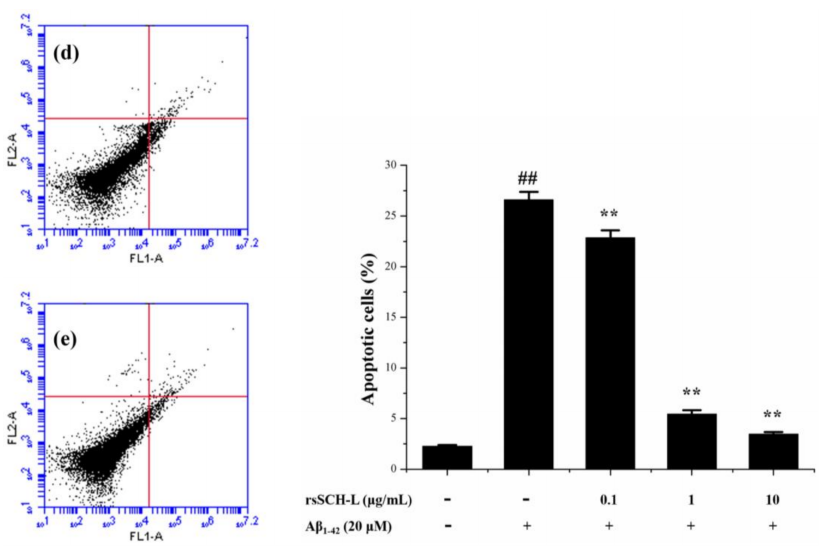
Figure 5. Effects of rsSCH-L on A β 1-42 -induced neuronal cell apoptosis, which was detected by